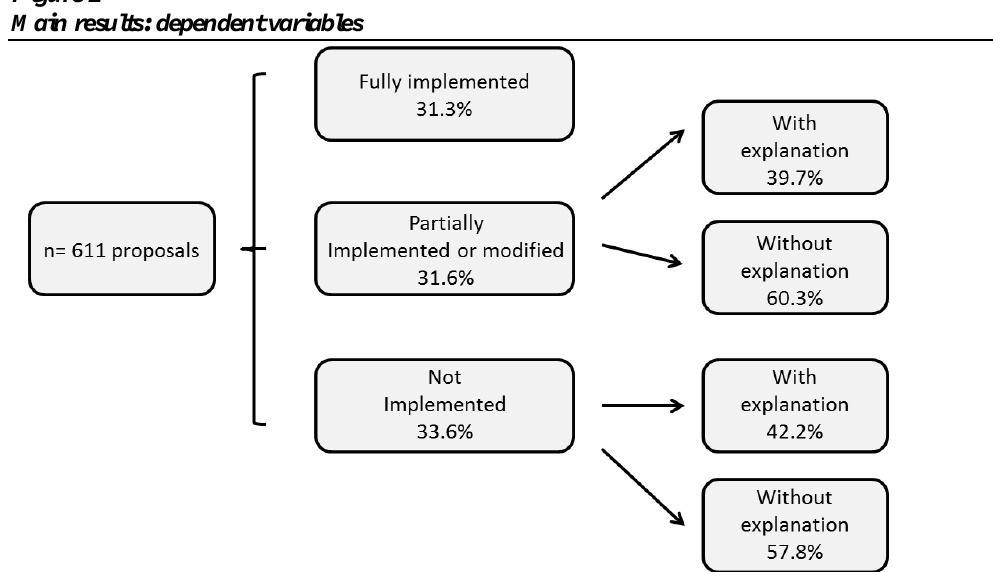
Main results: dependent